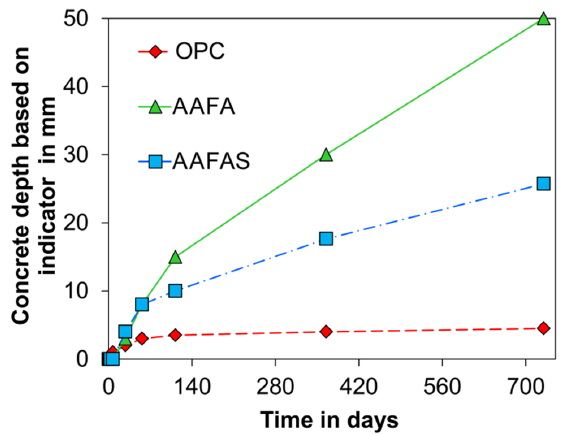
Figure 2. Depth of non-pink colored material in concrete were stored at 20 °C/65% rH, 0.04 Vol.-% CO 2.